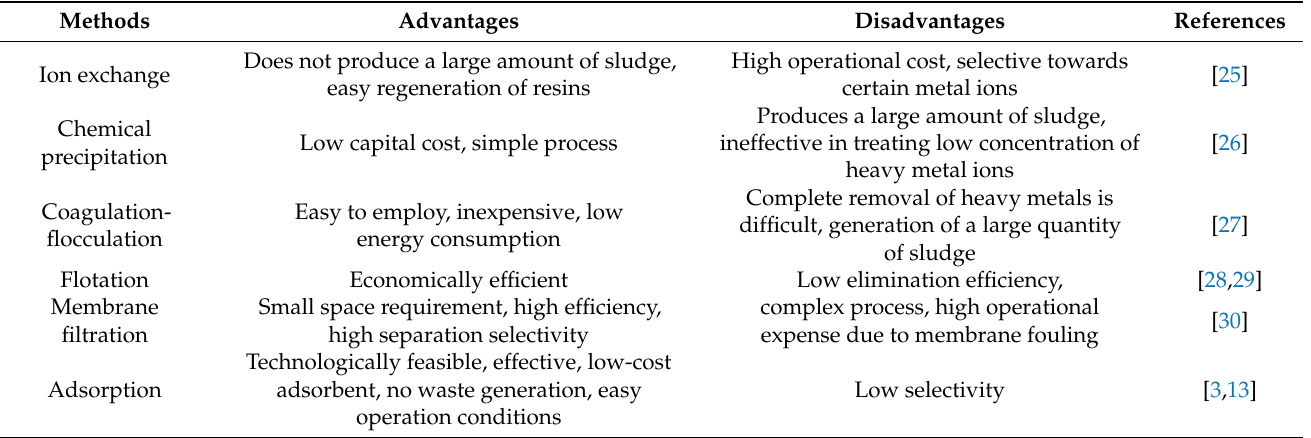
Table 2. Advantages and disadvantages of various methods used for recycling